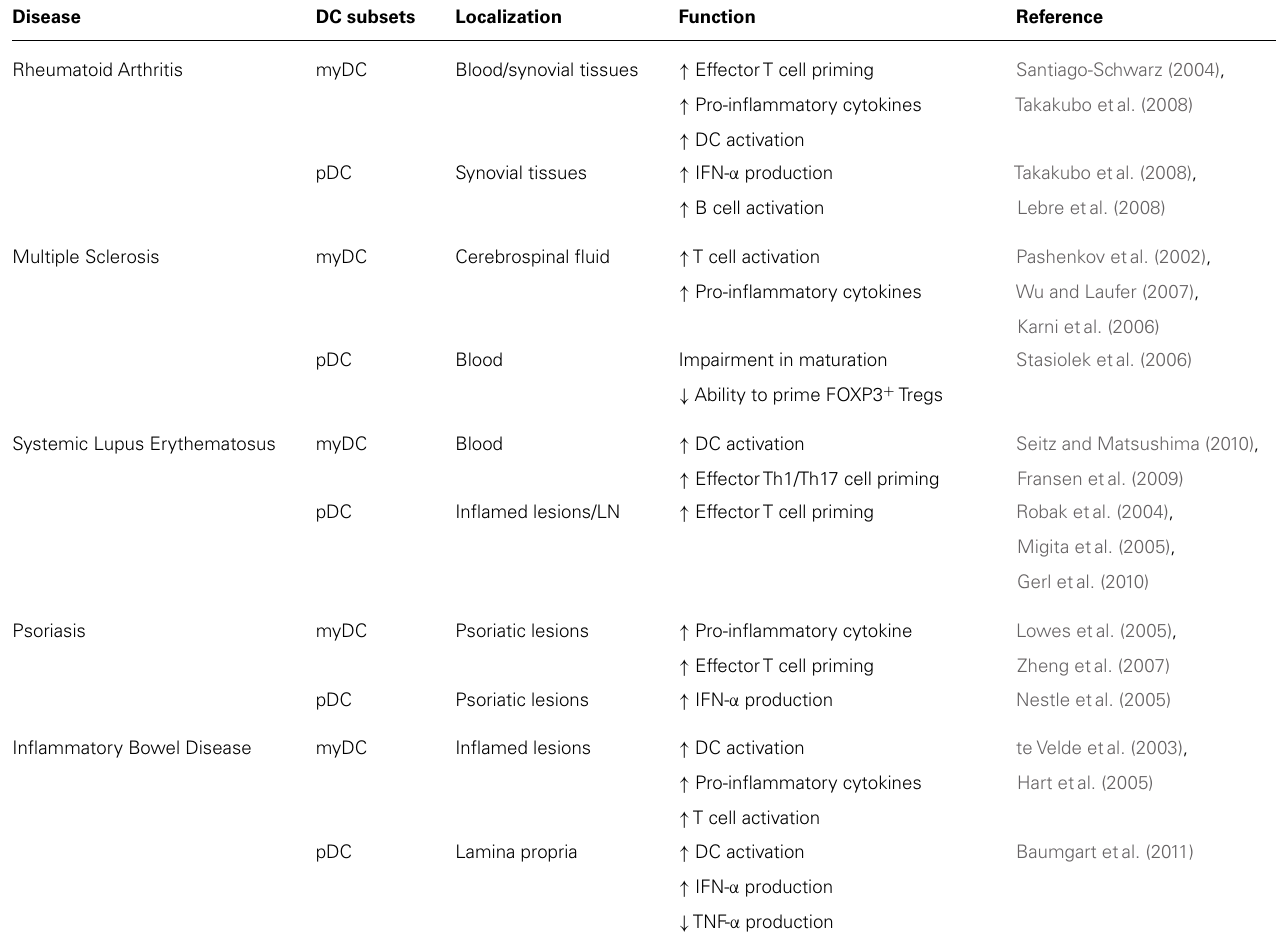
Table 2 | Role of dendritic cell subsets in human autoimmune